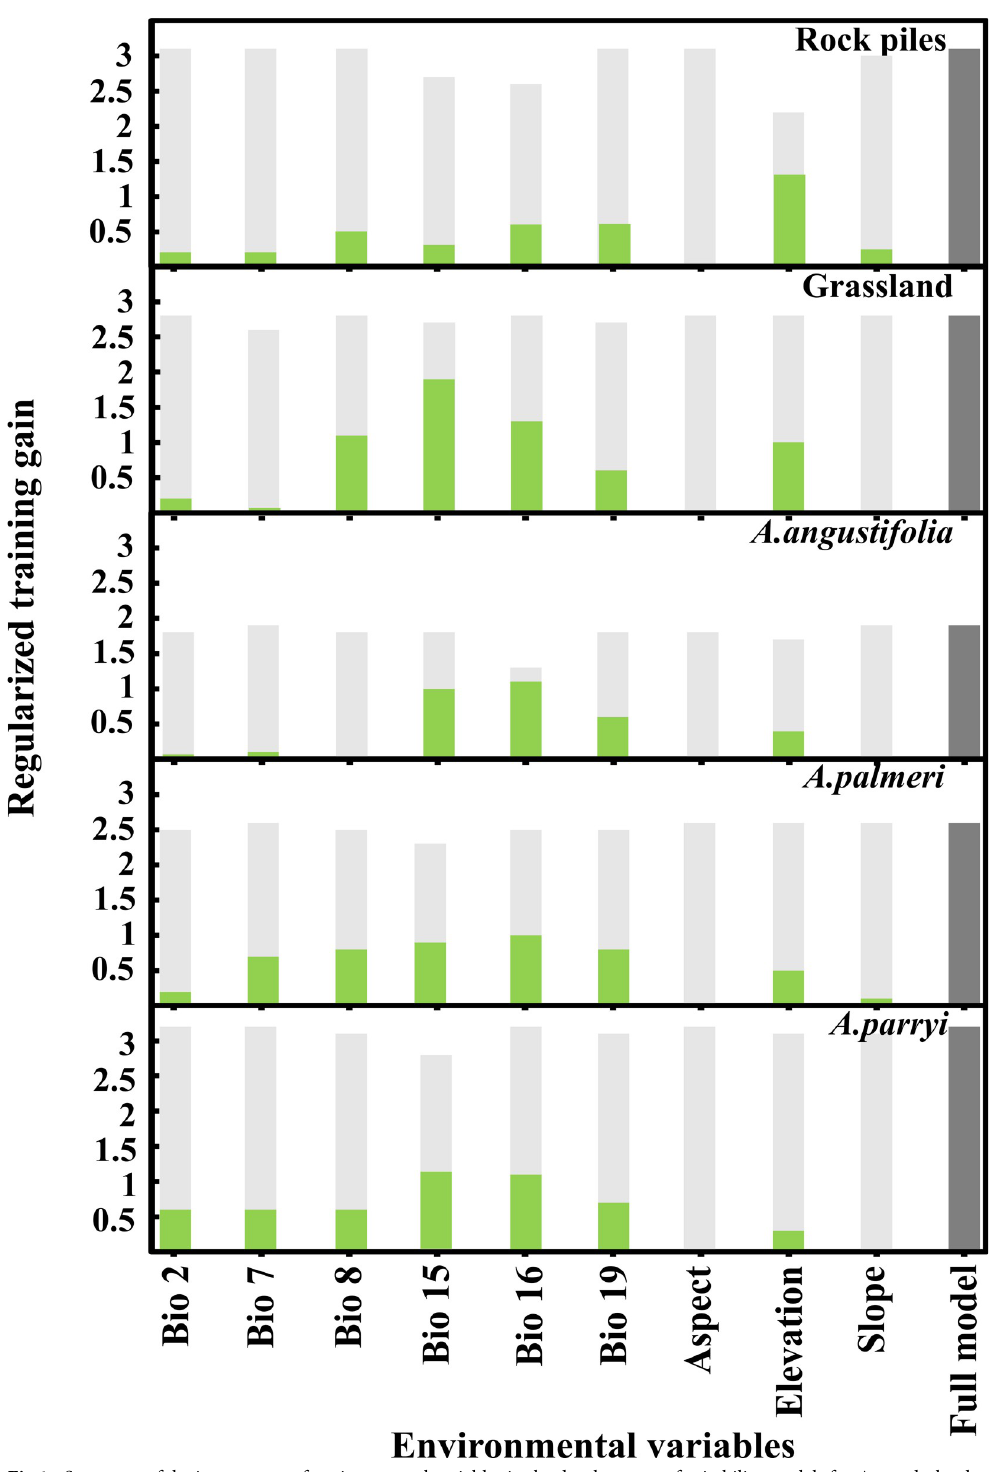
Fig 1. Summary of the importance of environmental variables in the development of suitability models for Agave dryland- farming (a, b) and Agave species (c, d, e) relative to regularized training gain. Green bars indicate model gain when only including individual environmental variables. Light-grey bars show the gain when the individual environmental variables are excluded from the full model. Dark-grey bars indicate the gain achieved in the full model, including all environmental variables in the model. Abbreviated environmental variables are defined as follows: Bio 2 = mean diurnal range (mean of